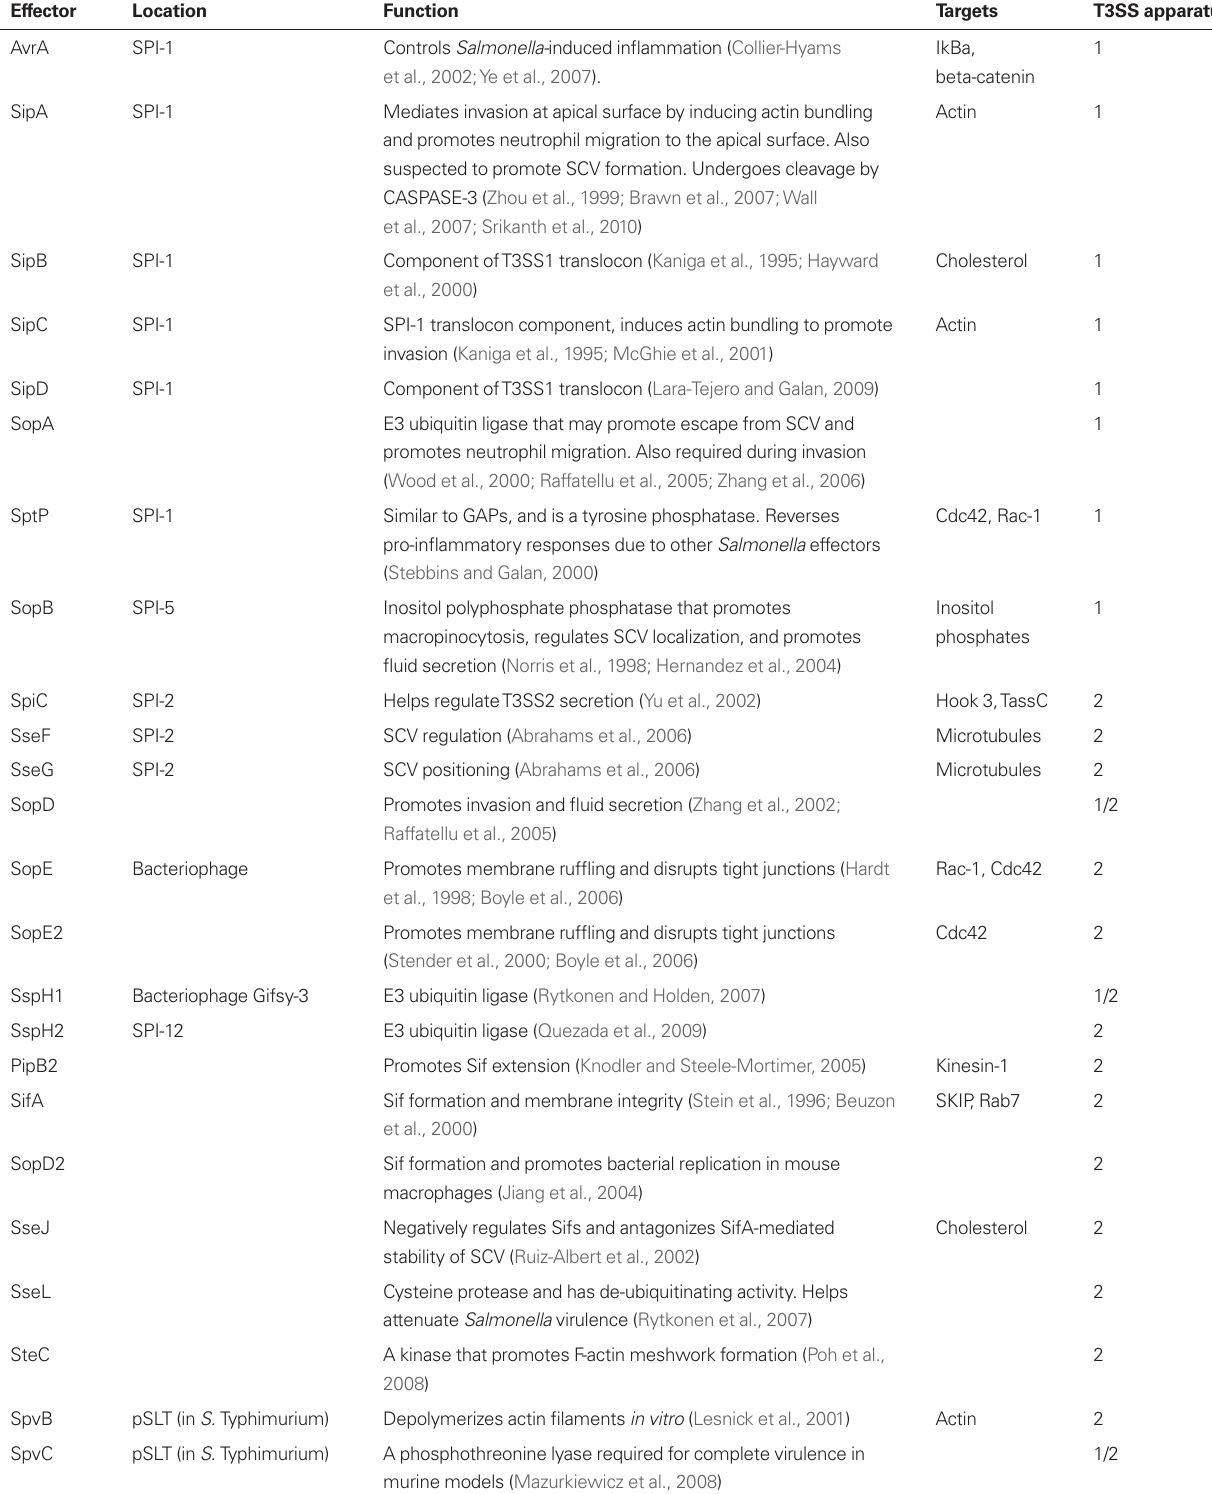
Table 1 | Salmonella effectors and their roles in pathogenesis.